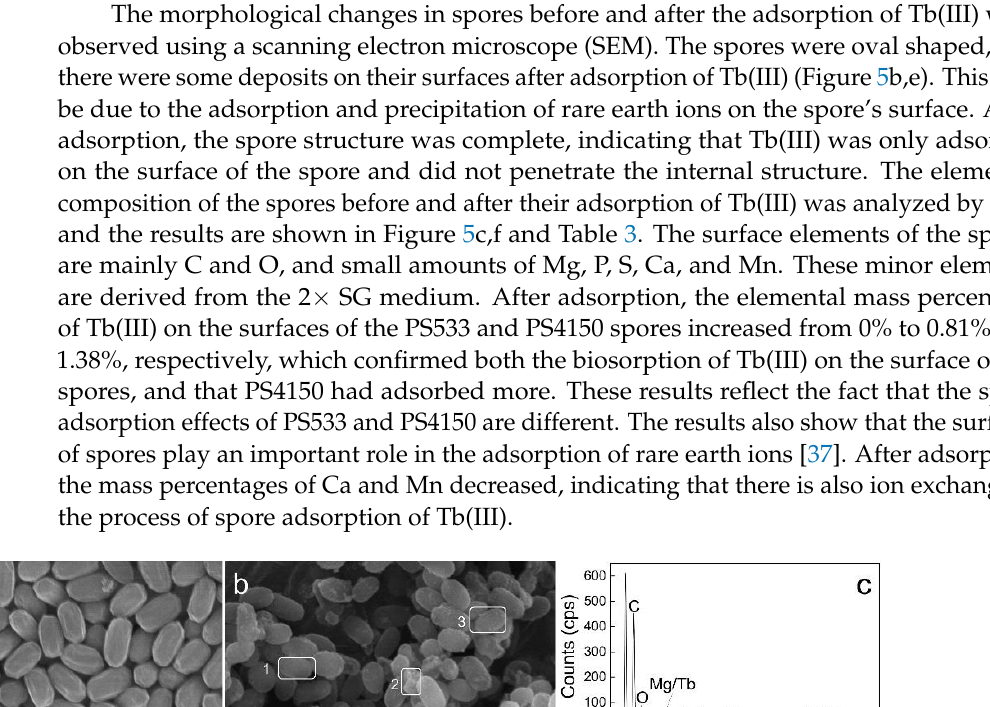
Figure 4. ( a ) The amount of Tb(III) adsorbed by B. subtilis PS533/PS4150 cells and spores were related to the concentration of Tb(III); ( b ) Langmuir isotherm model fitting; ( c ) Freundlich isotherm model fitting.